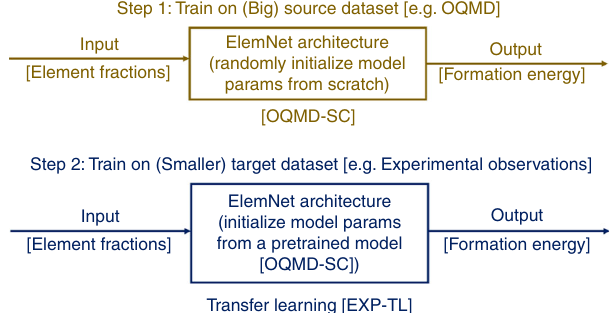
Fig. 2 Proposed approach of deep transfer learning. First, a deep neural network architecture (ElemNet) is trained from scratch, by initializing model parameters randomly from a uniform distribution, on a big DFT- computed source data set (OQMD). As this model is trained from scratch on OQMD, we refer to this as OQMD-SC model. Next, the same architecture (ElemNet) is trained on smaller target data sets, such as the experimental data set, using transfer learning. Here, the model parameters are initialized with that of OQMD-SC, and then fi ne-tuned using the corresponding target